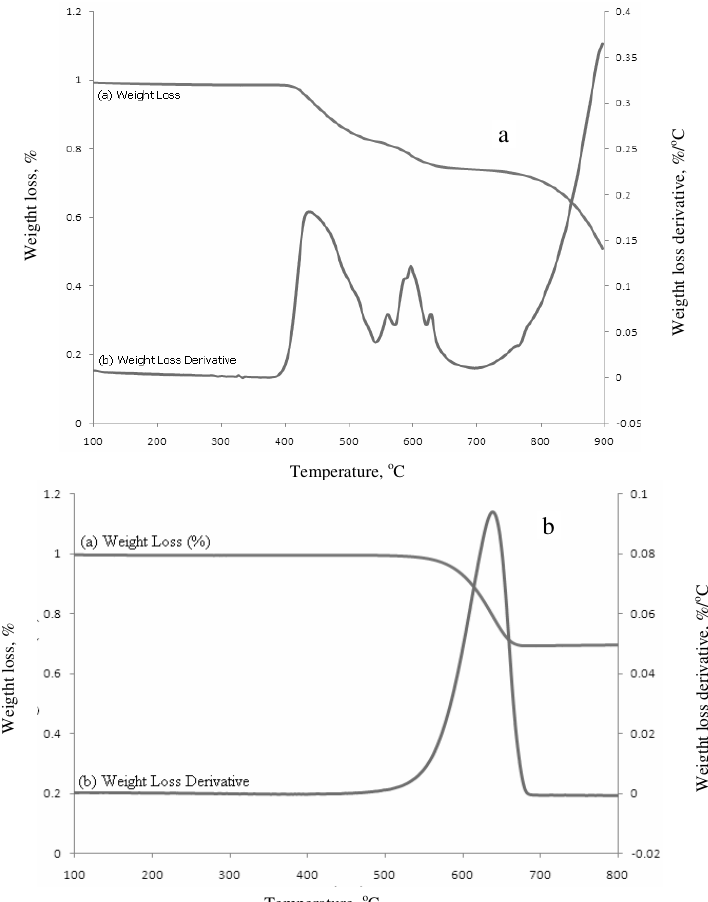
Figure 5. TGA and derivative thermogravimetric plot profile of MWCNT obtained from (a) Co/Zn/Al and (b) Fe/Ni/Al